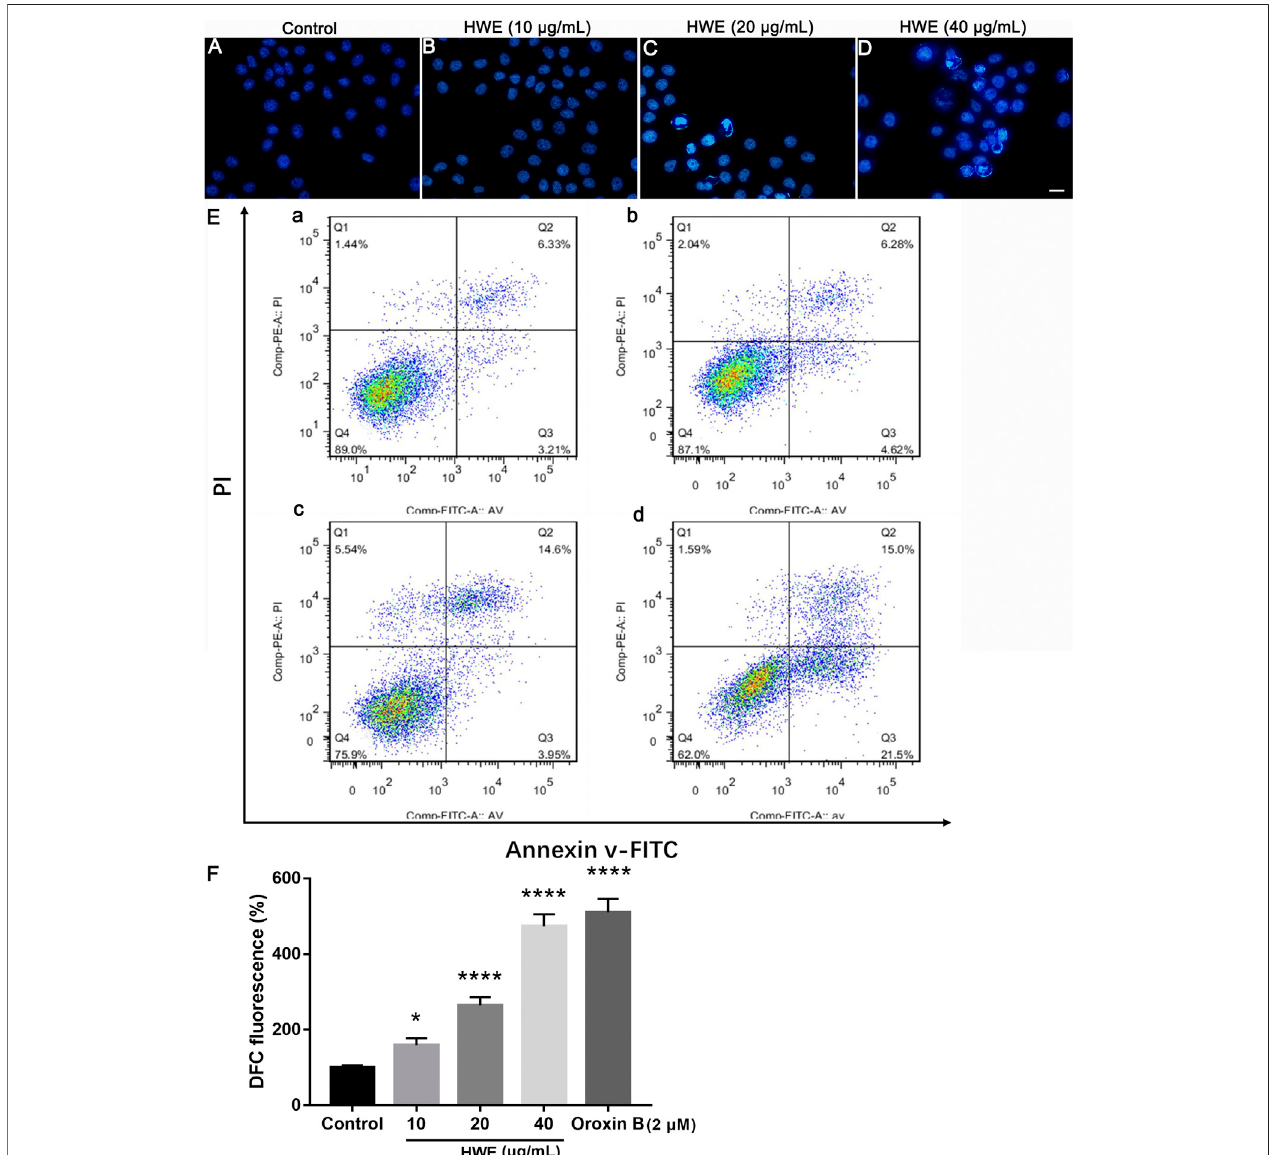
FIGURE6| EffectsofHWEonHepG2cellscellmorphologyandapoptosis. (A – D) Hoechst33,342stainingofHepG2cellswithorwithoutHWEtreated. (A) control group; (B) , 10 μ g/ml HWE treated group; (C) 20 μ g/ml HWE treated group; (D) 40 μ g/ml HWE treated group. Scale bar: 20 μ m. (E) FACS analysis of Annexin V/PI staining in HepG2 cells with or without HWE treated. (F) Quantitative analysis of FACS. The error bars denote SD. * p < 0.05 and **p < 0.01 vs control group.